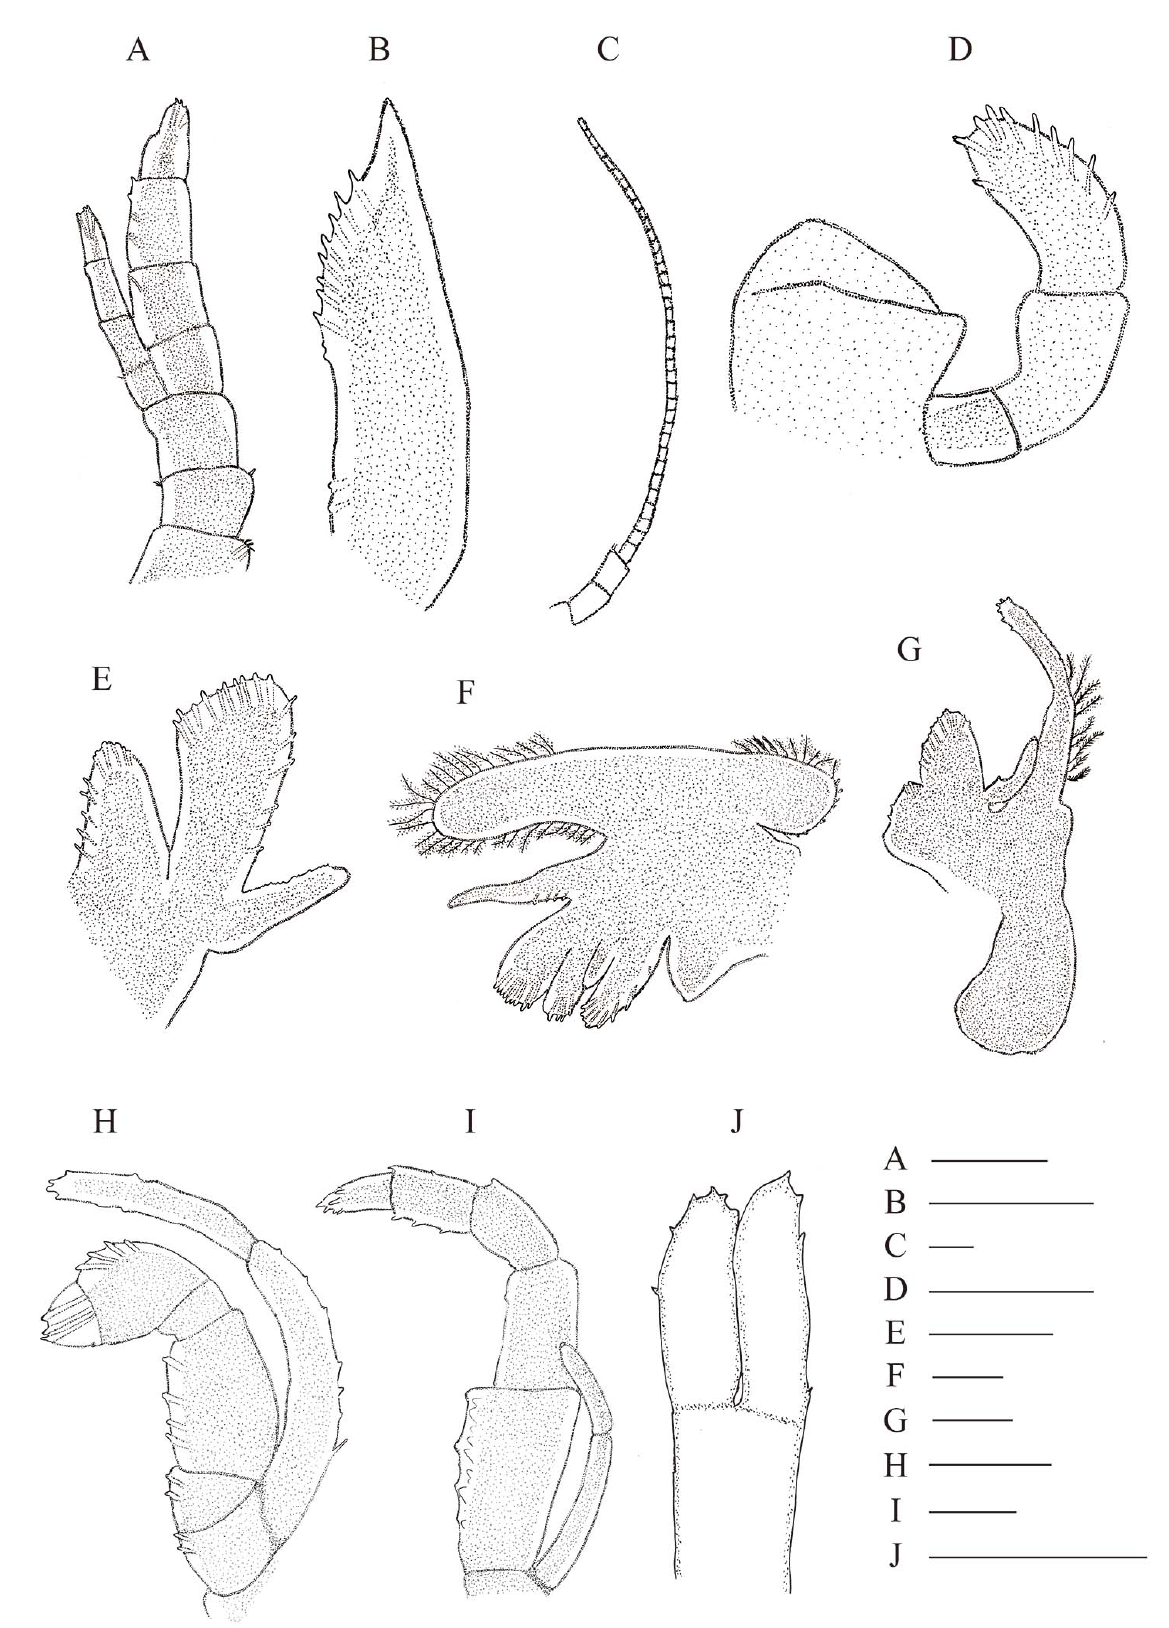
Figure 8. Juvenile Stage I of Procambarus virginalis . ( A ) Antenna 1, dorsal view; ( B ) antennal scale, dorsal view; ( C ) antenna 2, dorsal view; ( D ) mandible, view of inside of mouth; ( E ) maxilla 1, oral view; ( F ) maxilla 2, oral view; ( G ) first maxilliped, oral view; ( H ) second maxilliped, oral view; ( I ) third maxilliped, oral view; ( J ) pleopod. Scale bars: 0.25